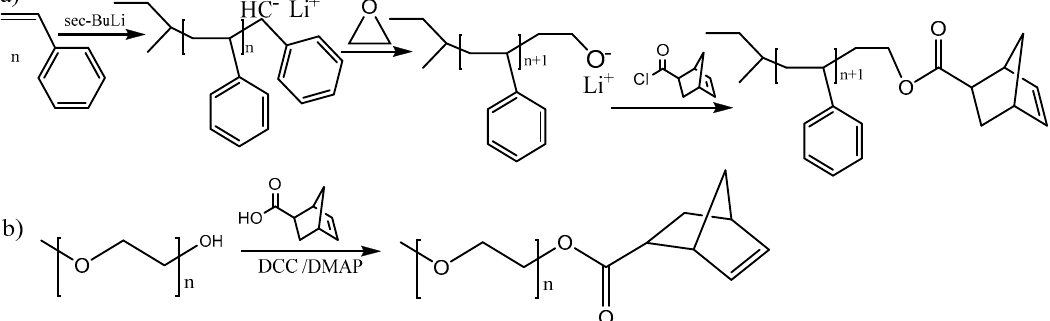
Figure 11. Examples of the syntheses of ω -monotelechelic macromonomers: ( a ) termination of anionic polymerization of styrene with NBE acyl chloride, ( b ) esterification of PEO–OH end group with NBE acid.